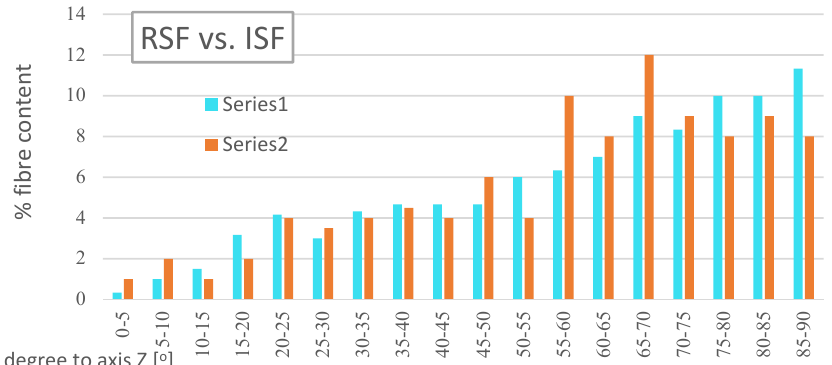
Figure 10. The average percentage fibre distribution in samples containing RSF fibres (Series 1) and ISF fibres (Series 2) in relation to their location, angle Θ , relative to the Z -axis.